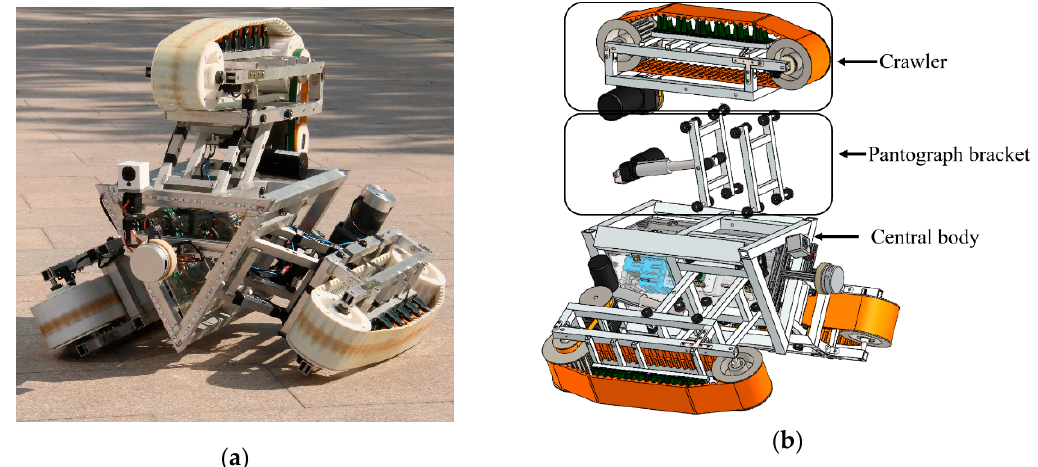
Figure 1. The large in-pipe robot. ( a ) Prototype. ( b ) Solid model.